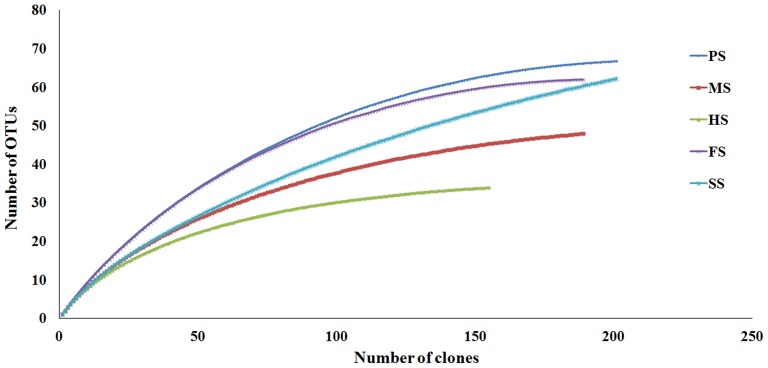
Rarefaction curves of GH10 xylanase fragments from six soil environments.The gene types were defined at the 6% cut-off. The curves represent the number of gene types as a function of total clones sequenced in libraries constructed from six soil genomic DNAs.